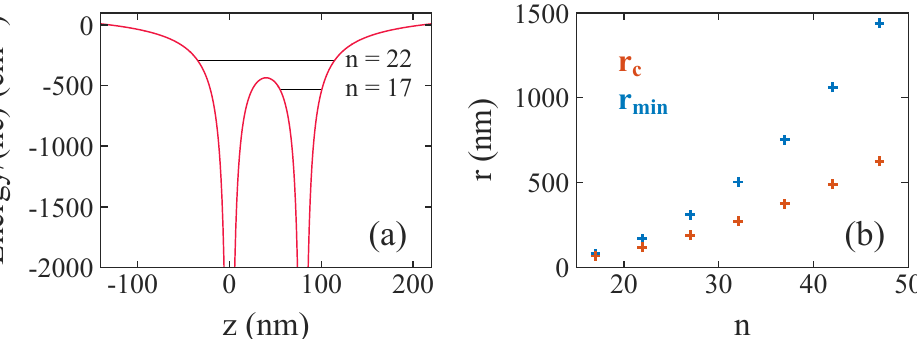
Figure 3. ( a ) Over-barrier motion. The red solid lines represent the Coulomb potential V Cou as given in Equation (11) for two ionic cores located at z = 0 and z = 80 nm on the z -axis (i.e., r = 80 nm) and an electron at position z . The black solid horizontal lines correspond to the energy of the unperturbed Rydberg level for n = 17 and n = 22, respectively. ( b ) Comparison of the critical internuclear distance r c to the internuclear distance r min where the minimum of the second outermost potential well associated with nP 1/2 states is located, as a function of n